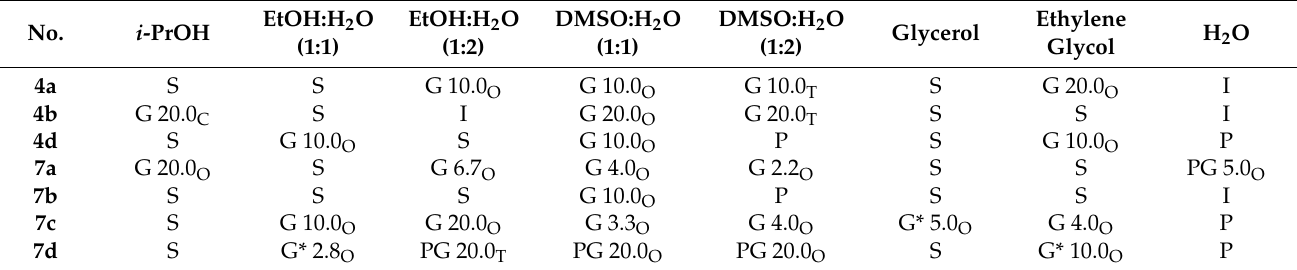
Table 1. Gelation test results of various triazole derivatives.